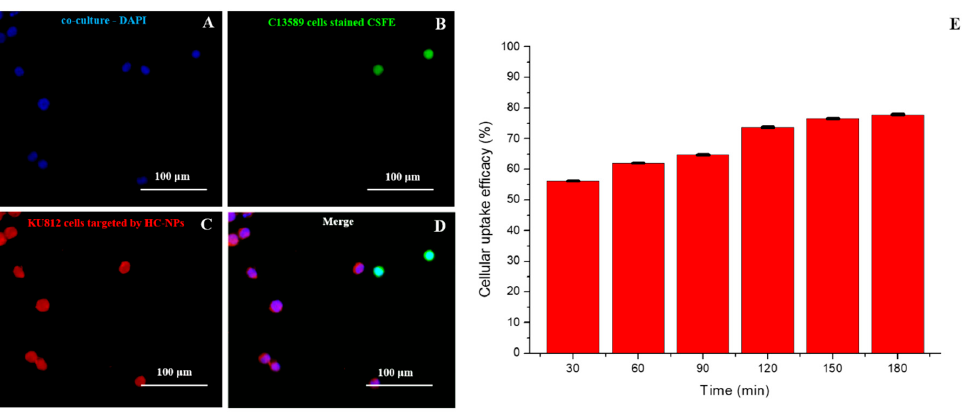
Figure 4 . Confocal Laser Scanning Microscopy (CLSM) images of C13589 and KU812 cell co-culture. ( A ) Cell nuclei were counterstained with 4 ′ ,6-diamidino-2-phenylindole (DAPI,blue), ( B ) C13589 cells before of co-culture were stained with commercial CSFE (carboxyfluorescein diacetate, succinimidyl ester) fluorophore (green), ( C ) KU812 cells present in the co-culture were recognized by HC-NPs functionalized with anti-CD38 monoclonal antibody (red), ( D ) merged confocal images. Scale bars: 100 µ m. Time-dependent cellular uptake e ffi ciency of HC-NPs by KU812 cells ( E ). Representative measurements of three independent experiments have been reported ( P -values <